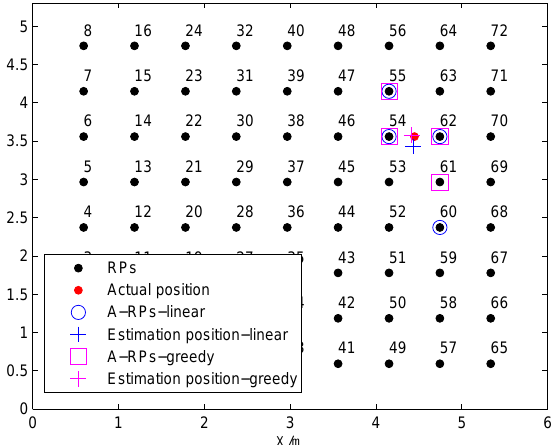
Figure 7. Adjacent RP searching results and position estimation results of the ninth test point based on two RP matching methods.